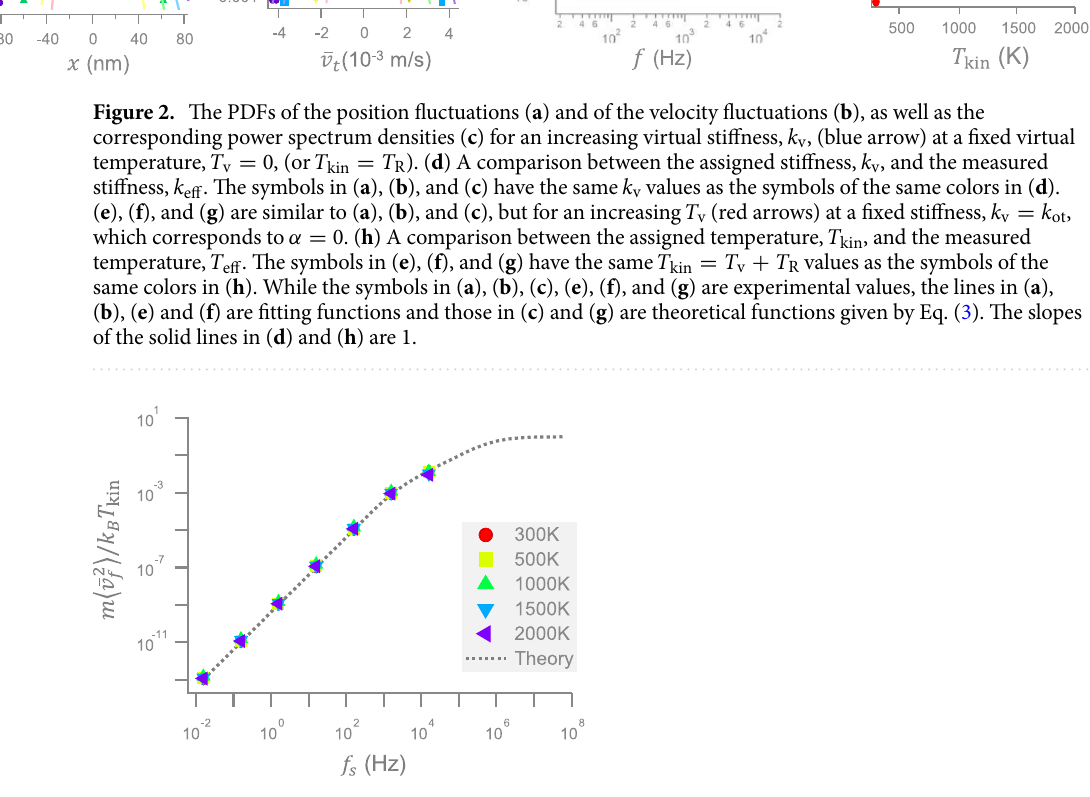
Figure 3. The average kinetic energy change inferred from the experimentally extracted time-averaged velocity in units of the thermal energy, k B T kin . The five types of symbol here have the same temperatures as those in Fig. 2e. The dashed curve is the theoretically derived kinetic energy change in Eq.